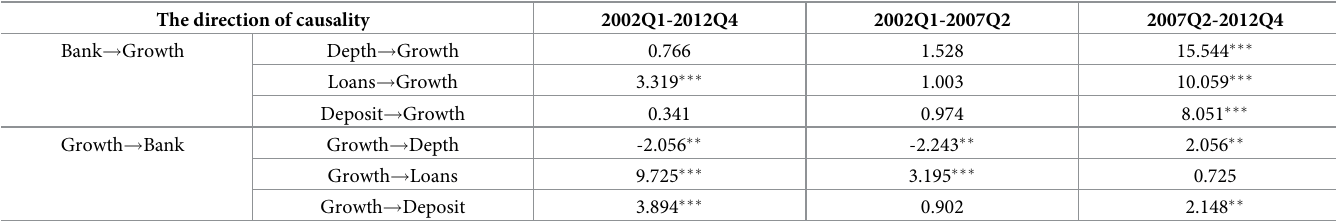
Table 7. Panel Granger causality